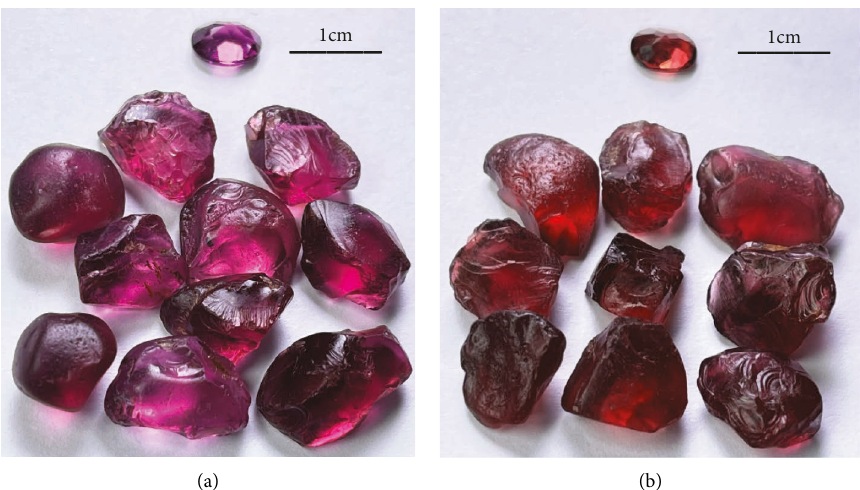
Figure 1: Malawi-mined (a) purplish-red and (b) maroon-red garnet